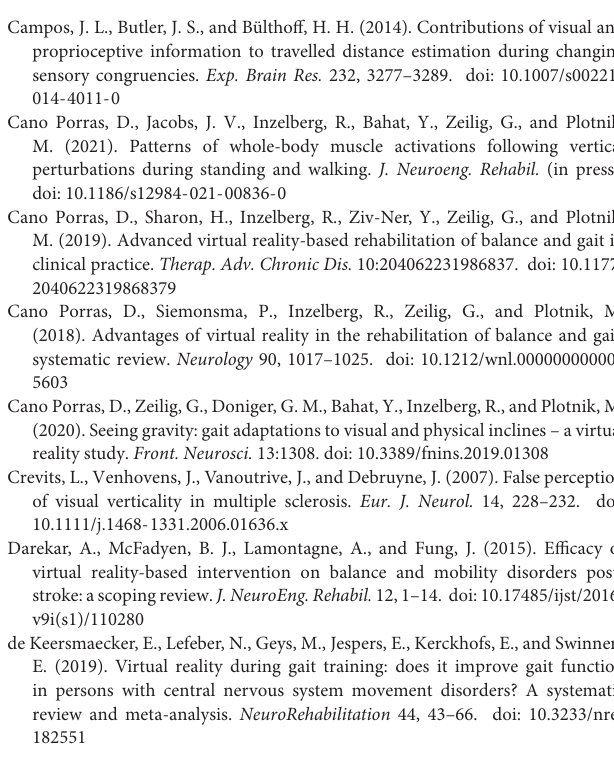
condition. The X -axis shows the sample rate (Hz), and the Y -axis shows muscle activation (mV). As can be seen, the pattern of activation remains similar for all the gait cycles pre-transition (purple frame) and post-transition (orange frame); the green frame represents the 5 s transition. Supplementary Figure 3 | Pre- vs. post- EMG right Gastrocnemius activation patterns for visual-physical congruent uphill walking. Grand average (across participants, N = 12) of muscle activation patterns ( Y -axis, in mV) plotted against a time-normalized gait cycle on the X -axis (in % of the gait cycle) in blue (shaded areas represent SE) for pre-transition and in orange (shaded areas represent SE) for 20 s post-transition. Numerical values at top left represent averaged summation (area under the curve) magnitude of activation ± SE for pre-transition (blue) and post-transition (orange), asterisks denote a significant post- vs. pre-transition change (two-tailed, paired T -test, ∗ P < 0.05). The normalized change appears below (in %) in parentheses. Supplementary Table 1 | No significant difference in the patterns of muscle activation between Cano Porras 2020 and the recent study. Each row represents a walking condition (see section “Materials and Methods” for details). The 2nd and 3rd columns represent the average values for the relative peak change from SSV (%) ± SE. The 5th and 6th columns represent the average time of peak effect (seconds) for each study ± SE. The 4th and last columns represent the p -value obtained from a paired two-tailed t -test. ∗ ( N = 14), ∗∗ ( N = 12). A Kruskal–Wallis test showed that the magnitude of relative speed change was significantly affected by condition ( p = 0.002). Post hoc analyses revealed that the effect originated from the difference in relative speed change between TUVD and (i) TLVD ( p = 0.04), and (ii) TDVU ( p = 0.03). All other dichotomic comparisons were not found statistically significant ( p ≥ 0.185). Supplementary Video 1 | The video insert depicts the behavior effects of visually induced downhill walking. Initially, the person is walking with the treadmill, and the visual scene leveled. Once the person reaches steady-state velocity and maintains it for 12 s, a downward transition of the visual scene occurs, while the treadmill remains leveled. Note how she decreases her gait speed to counteract the expected gravitational forces (i.e., the braking effect). Eventually, body-based cues govern, and gait speed returns to the previous steady-state